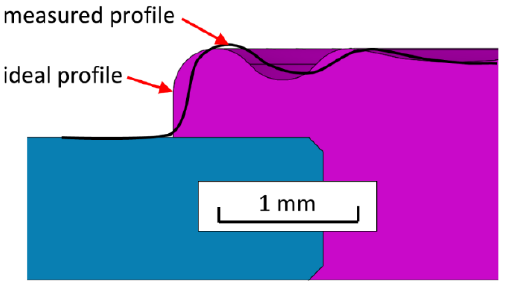
Figure 27. Investigation of the manufactured sealing lip; contour comparison of CAD (edge of the pink area) and manufactured rubber (bold black line) measured via white light scanning.